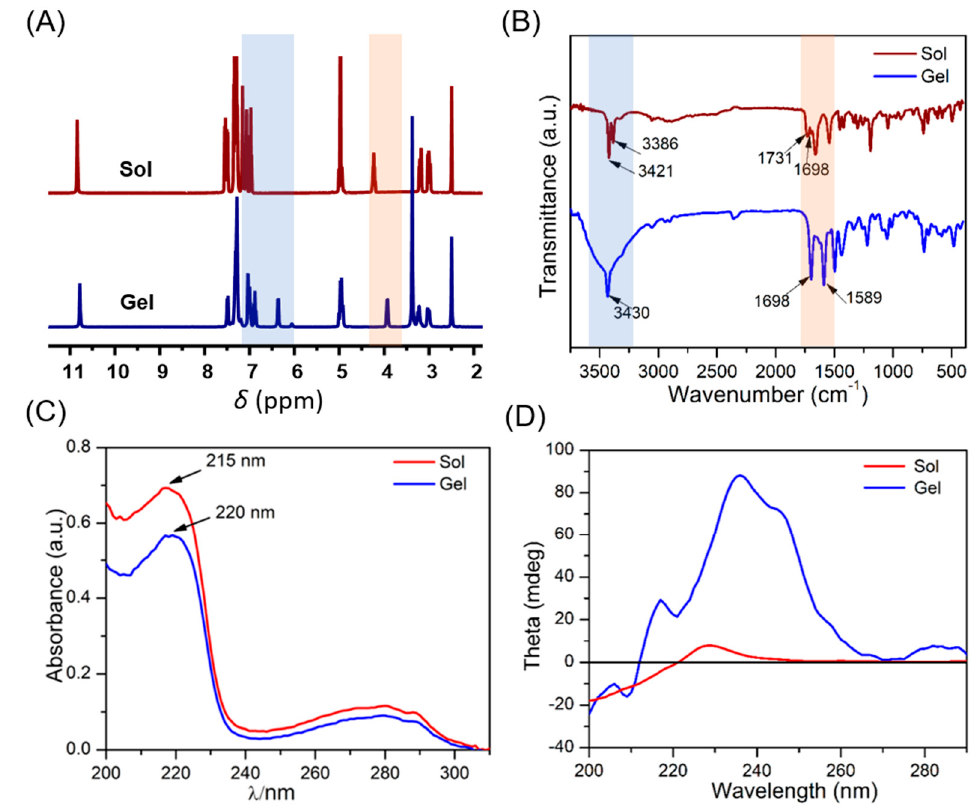
Figure 3. ( A ) 1H NMR spectra, ( B ) FT-IR spectra, ( C ) UV-Vis spectra, and ( D ) CD of ZW solution and ZW/GDL hydrogel (pH 6.0).